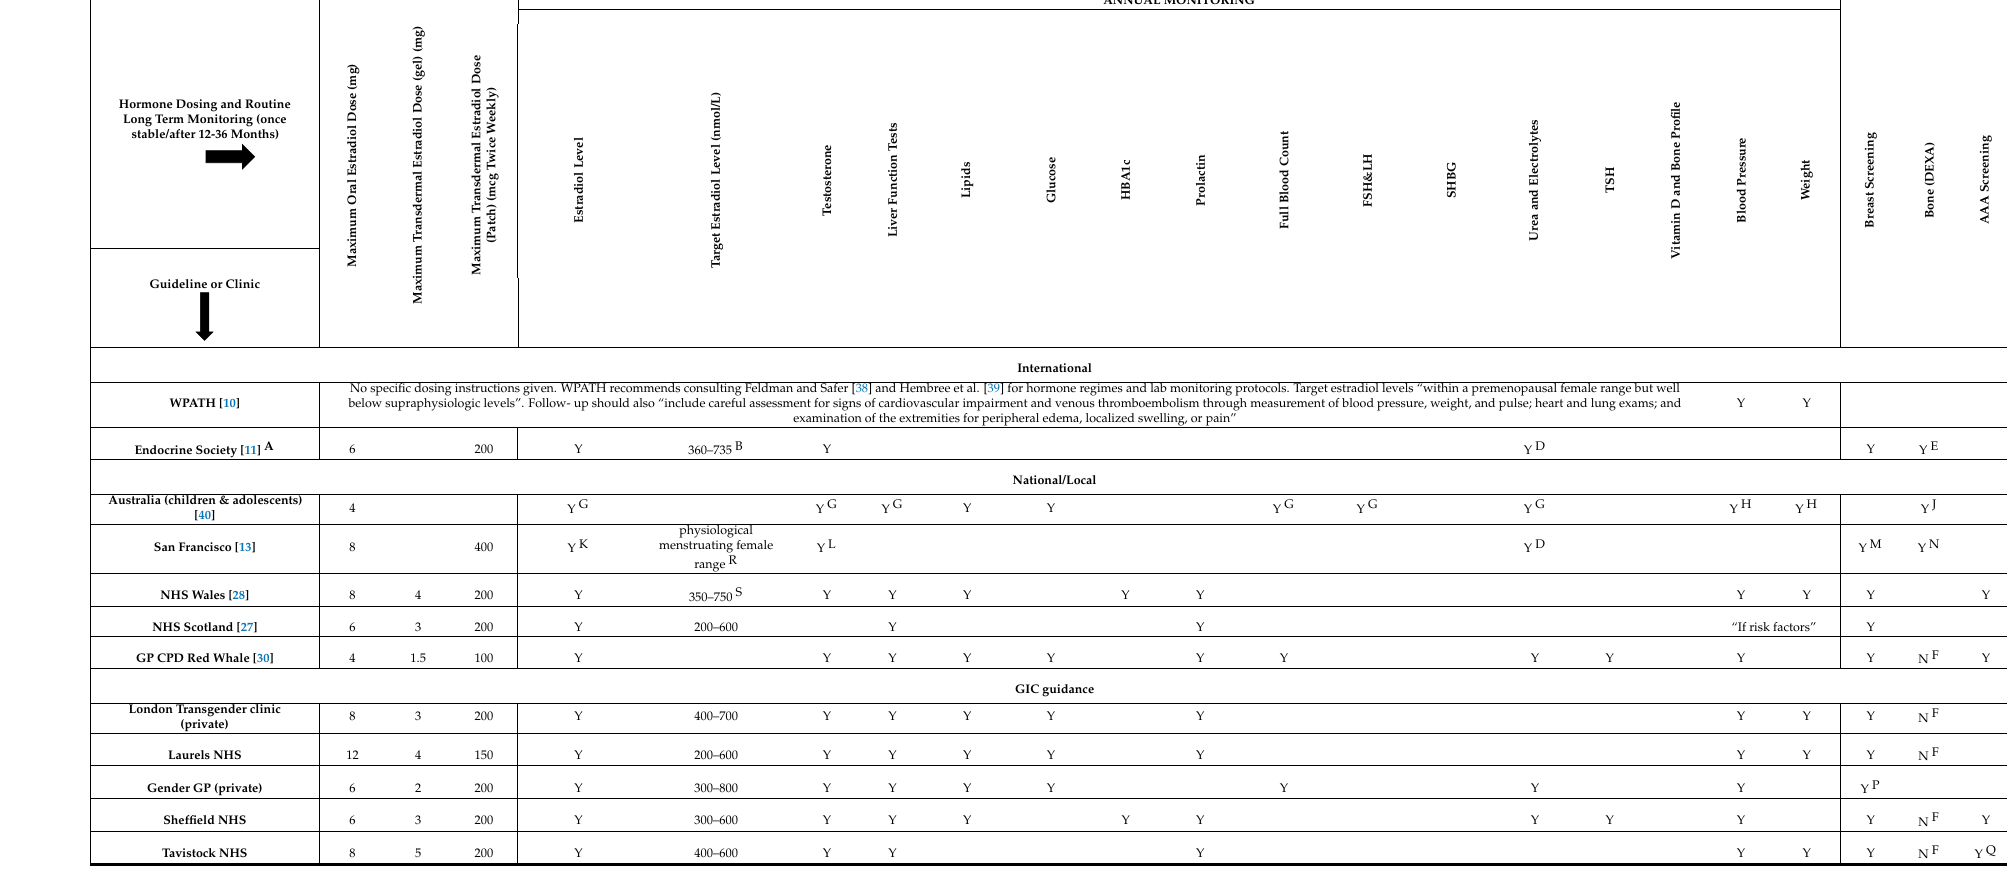
Table 2. Comparison of national, international, and patient specific prescribing and monitoring guidelines for trans women (observed males at birth) with gender dysphoria.